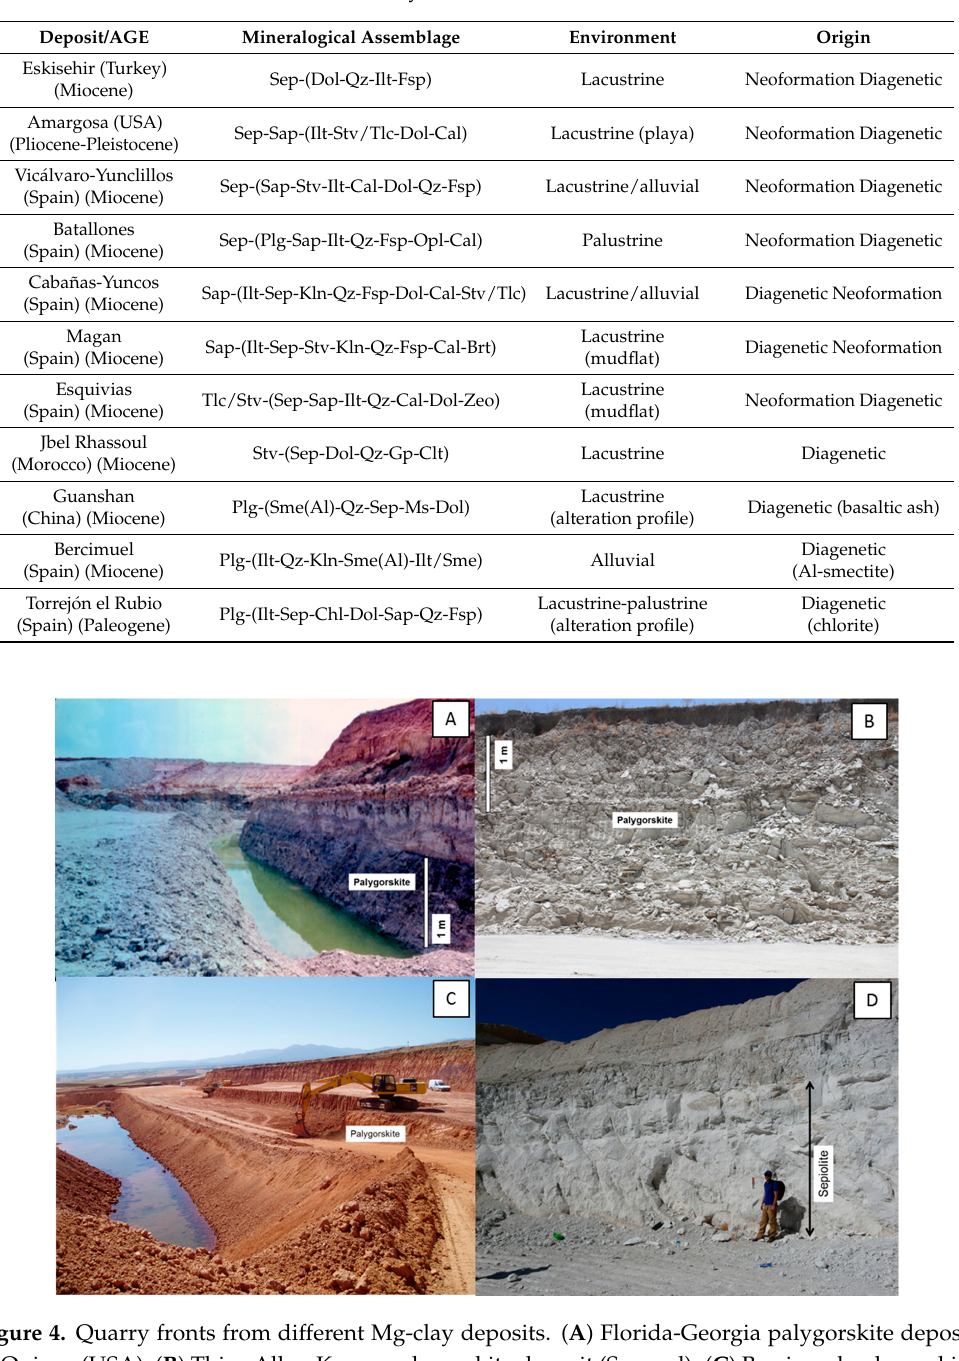
Table 2. Most important magnesian clay deposits occurring in Cenozoic continental formations.